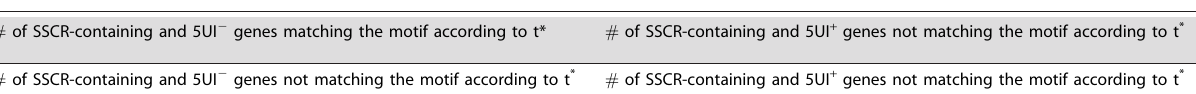
Table 1. 2 6 2 Contingency Table to determine PSSM threshold